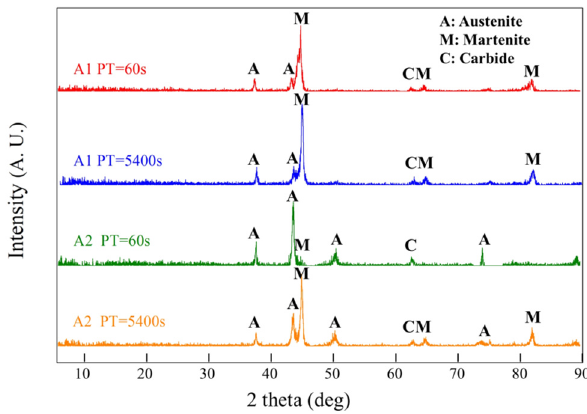
tenite point ( b ) of Figure 7 ( b )) , the hardness of alloy A1